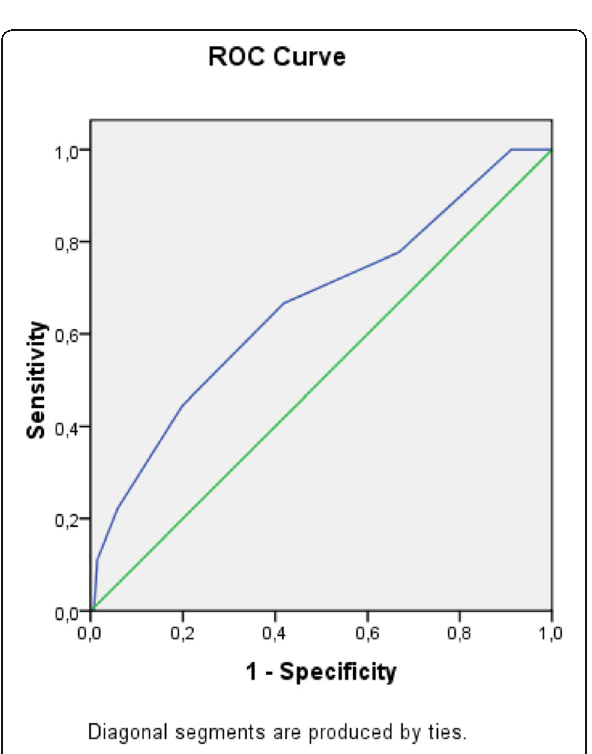
Fig. 2 ROC curve for Ranson